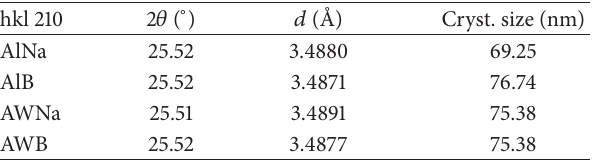
Table 4: Diffraction angle, reticular space, and crystallite size of the hkl index 210.